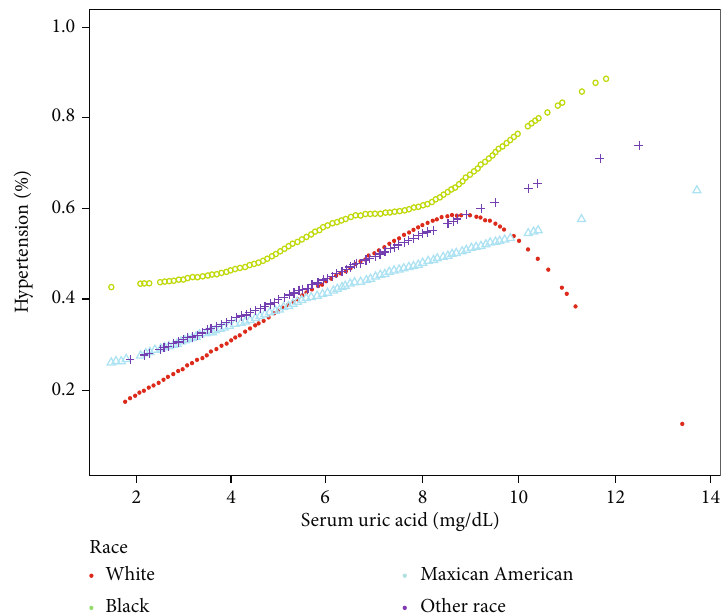
Figure 4: Association between sUA and HTN, strati fi ed by race. Age, sex, income-poverty ratio, physical activity, smoking behavior, alcohol consumption, diabetes mellitus status, body mass index, total cholesterol, serum homocysteine, urine creatinine, blood urea nitrogen, and total calcium were adjusted. Table 4: Threshold e ff ect analysis. Serum uric